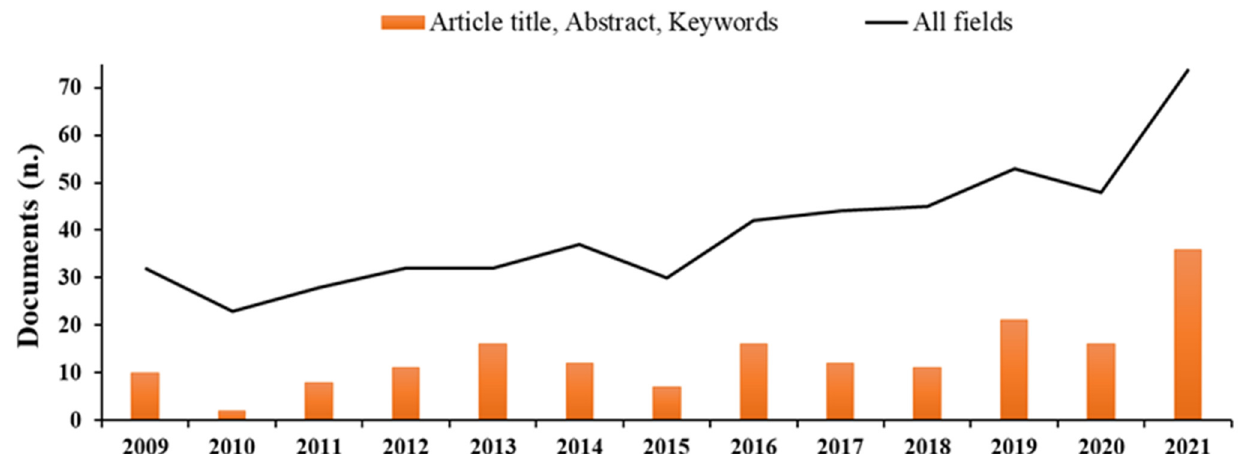
Figure 2. Number of documents available on Scopus through searches with keywords ‘basic substances’ in ‘Article title, Abstract, and Keywords’ (histograms) or in ‘All fields’ (linear) published